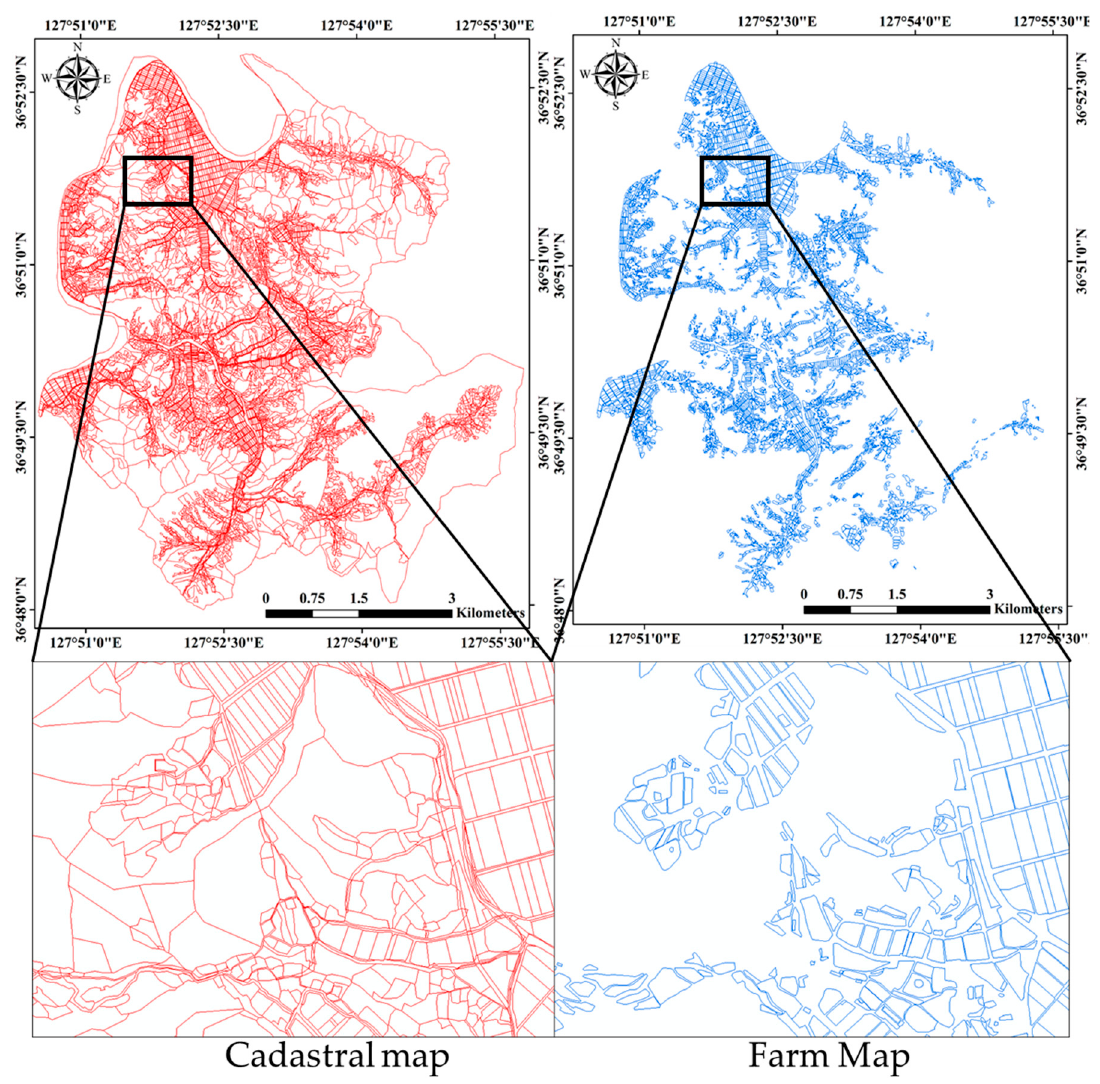
Figure 10. A comparison of the farmland boundary based on the Farm Map and cadastral map. Table 4. Number of fields and cultivation area of corn and other crops for the entire agricultural land area in Gammul-myeon.